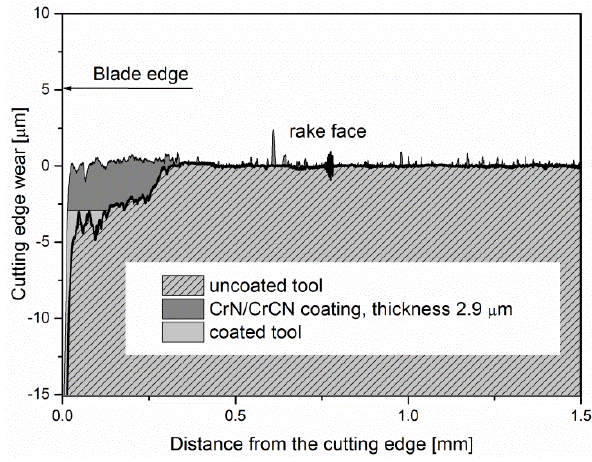
Figure 4. The cutting edge profile of planer knife with CrN/CrCN multilayer coating after 6000 m of dry beech wood cutti ng [83]. dry beech wood cutting